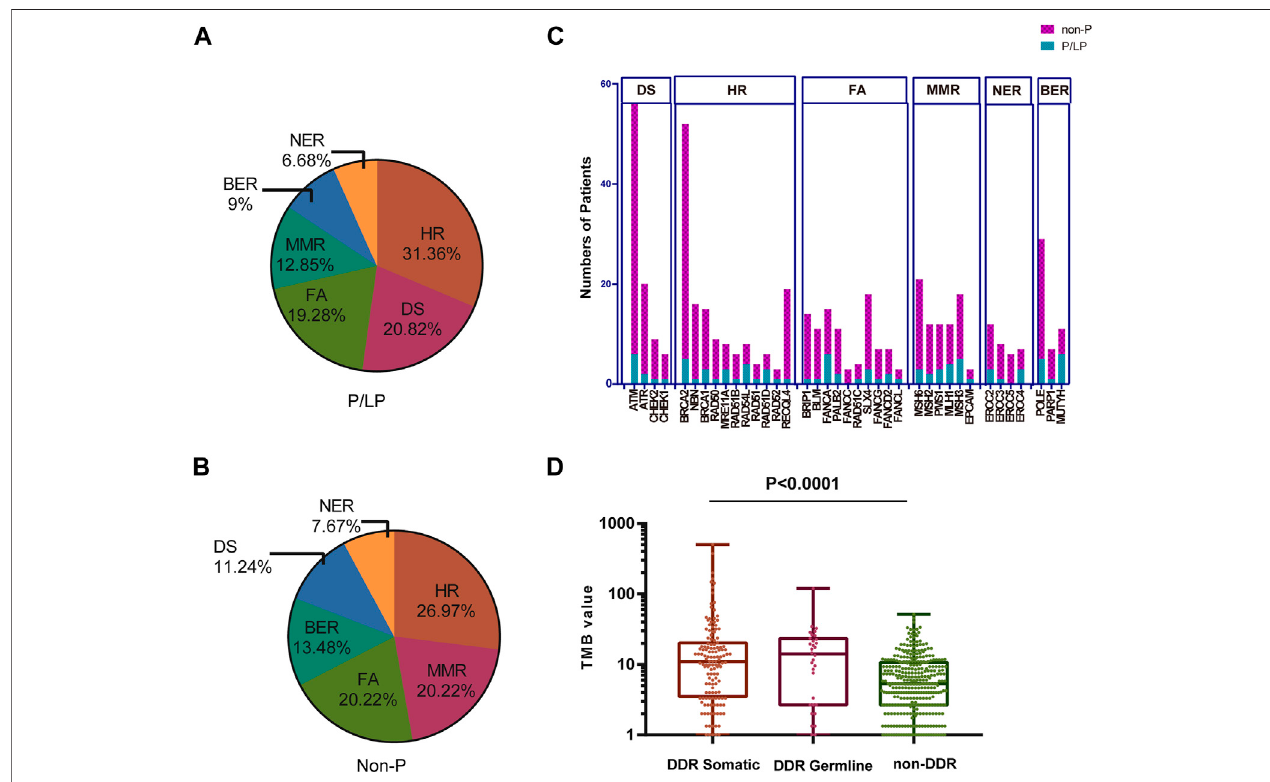
FIGURE5| PercentageofpatientswithbowelcancerharboringDDRgenemutationsandtheTMBinourcohort.TheproportionofdifferentDDRpathwaysinP/LP (A) and Non-P groups (B) . (C) Comparison of the number of patients with gene mutations in DDR pathways for P/LP and Non-P groups. (D) Comparison of the TMB from somatic mutations of the DDR somatic, DDR germline, and non-DDR groups. P/LP: pathogenic/likely-pathogenic; DDR: DNA damage response; TMB, tumor mutation burden.